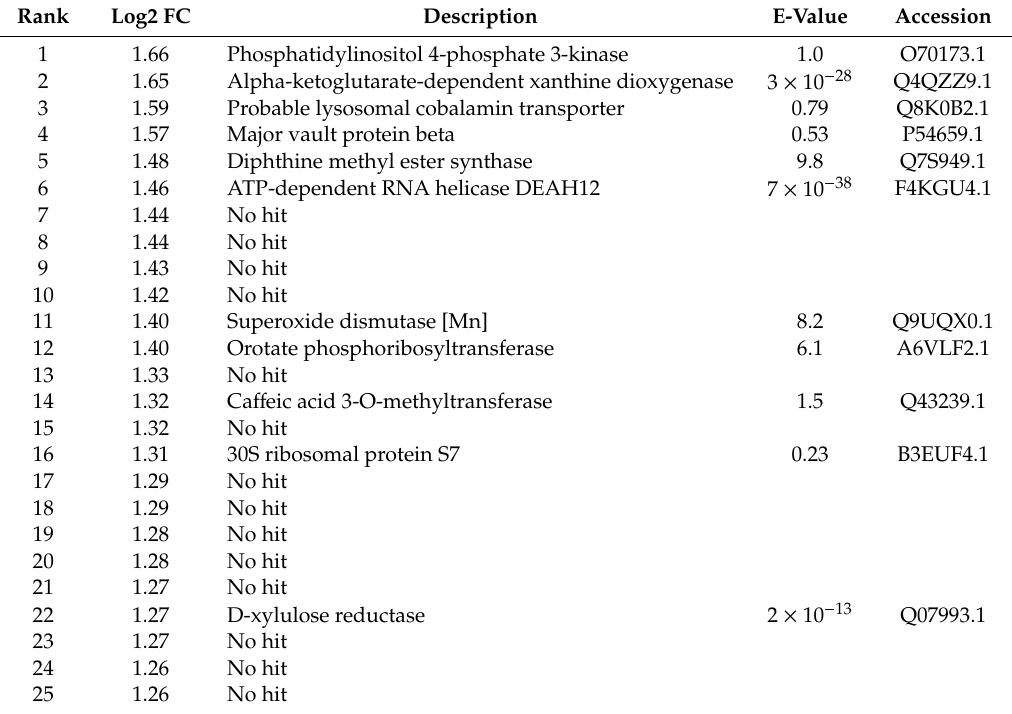
Table A2. Top 25 up-regulated transcripts of Inonotus obliquus library in library of cells cultivated in presence of betulin.